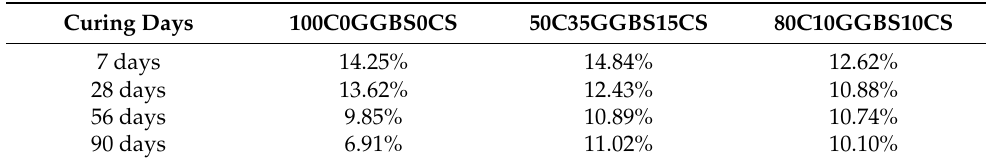
Table 10. Mix total